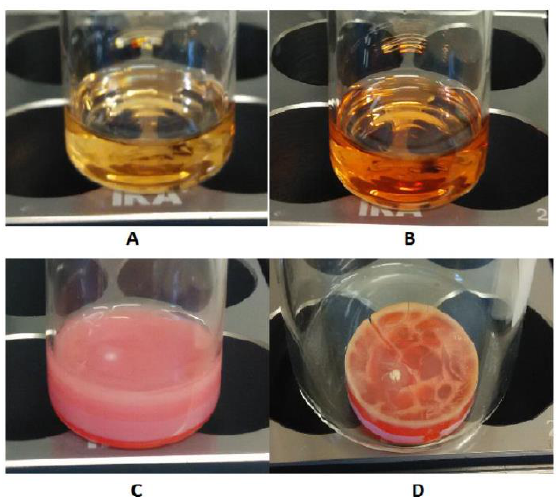
Figure 1. ( A ) The MIP-10 polymerization mixture immediately before the addition of diclofenac; ( B ) The MIP-10 polymerization mixture after the addition of diclofenac; ( C ) The non-imprinted polymer (NIP) polymerization mixture immediately after gelation; ( D ) The MIP-10 polymerization mixture after complete gelation. MIP-10: molecularly imprinted polymers (MIPs) prepared by template addition 10 min from the start of the polymerization.